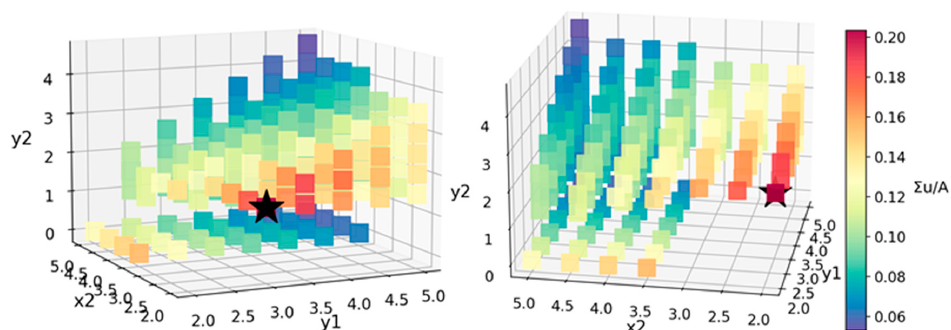
Figure 13. The three-dimensional scatter diagram of array power density (truncation ratio is 0.5). The missing scatters represent that the inflow velocity under this distance parameters is less than the truncation ratio. The left and right pictures are two different side views of the scatter. The three axes are the three distance parameters ( y 1, x 2, y 2). The color bar represents the array power density. The black star represents the maximum array power density (its coordinates are y 1 = 3, x 2 = 2, y 2 = 1.5).